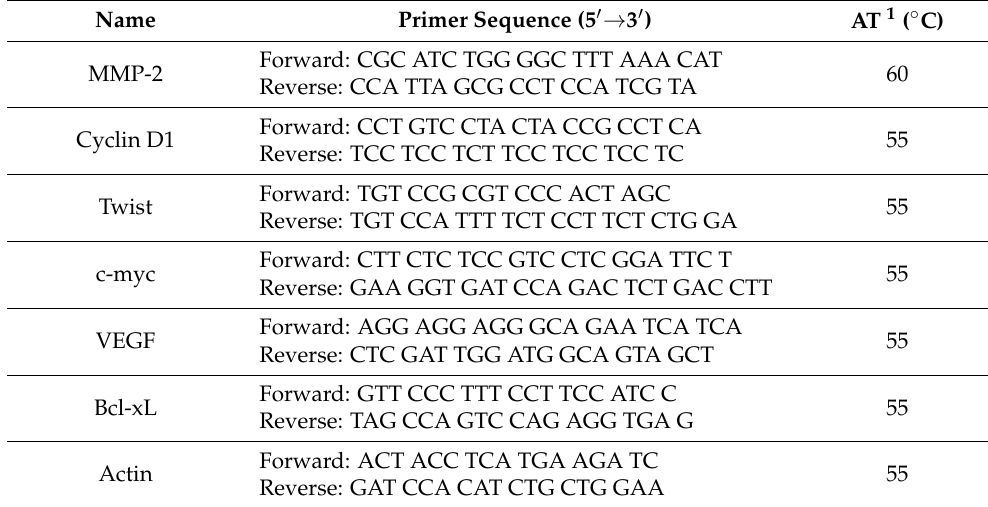
Table 2. Primer sequence and annealing temperature for each